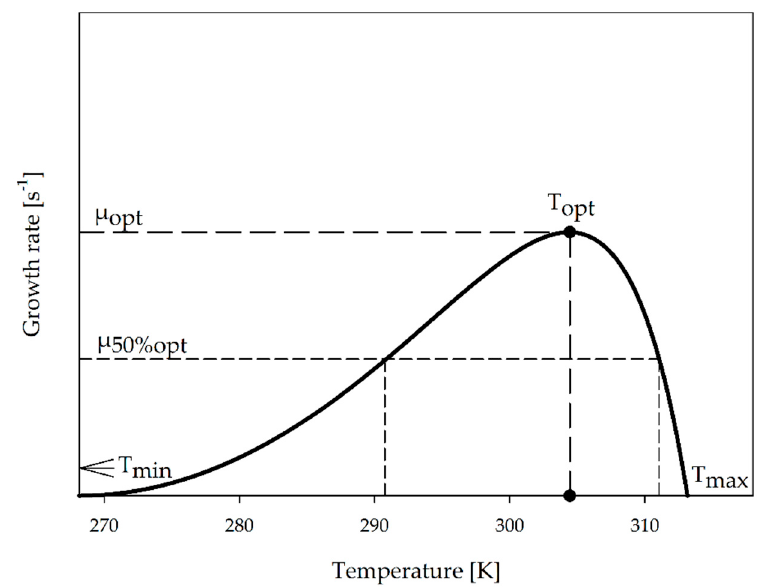
Figure 2. Scheme of the thermal growth curve where the temperature (K) is plotted against the growth rate (s − 1 ). Cardinal temperatures ( T min , T opt , and T max ) with their corresponding growth rates ( µ opt and µ 50%opt ) are indicated.